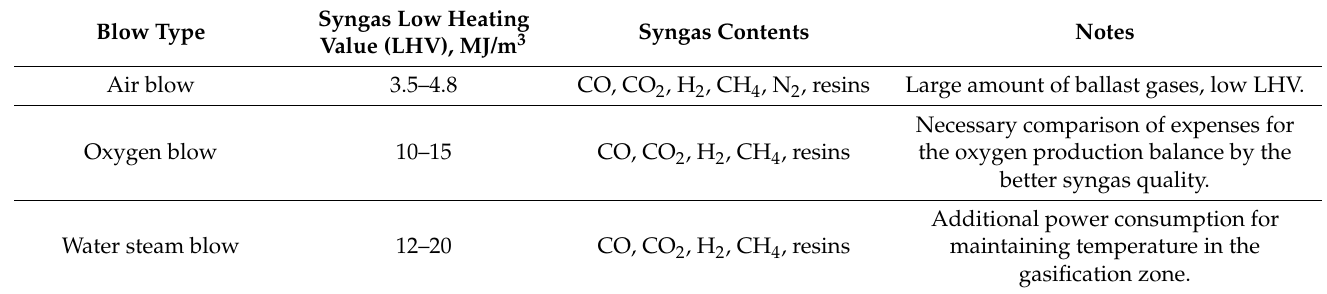
Table 1. Comparison of solid fuel gasification